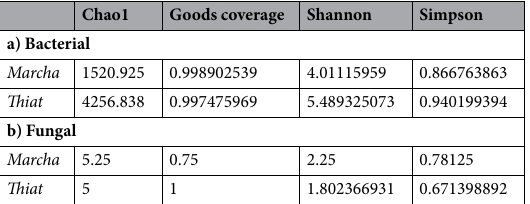
Chao1 Goods coverage Shannon